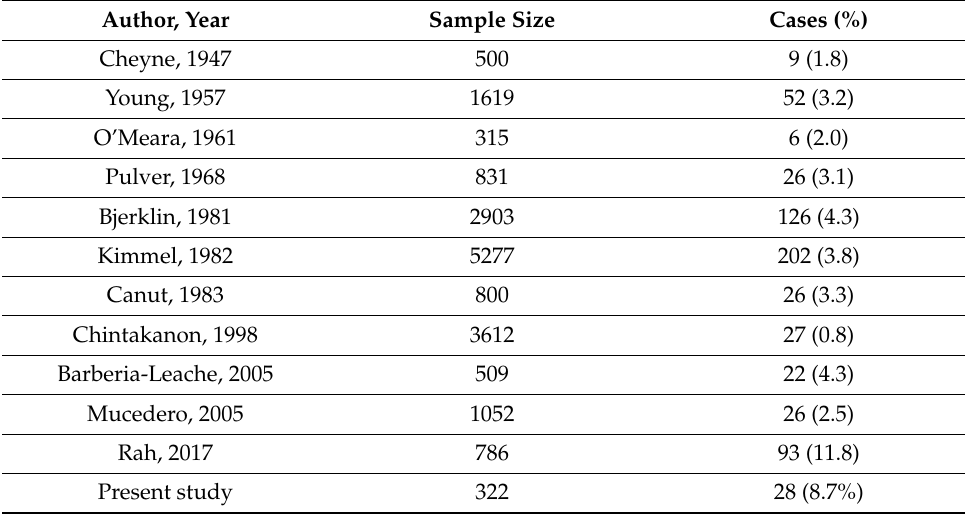
Table 5. Ectopic eruption of the maxillary first permanent molar prevalence data